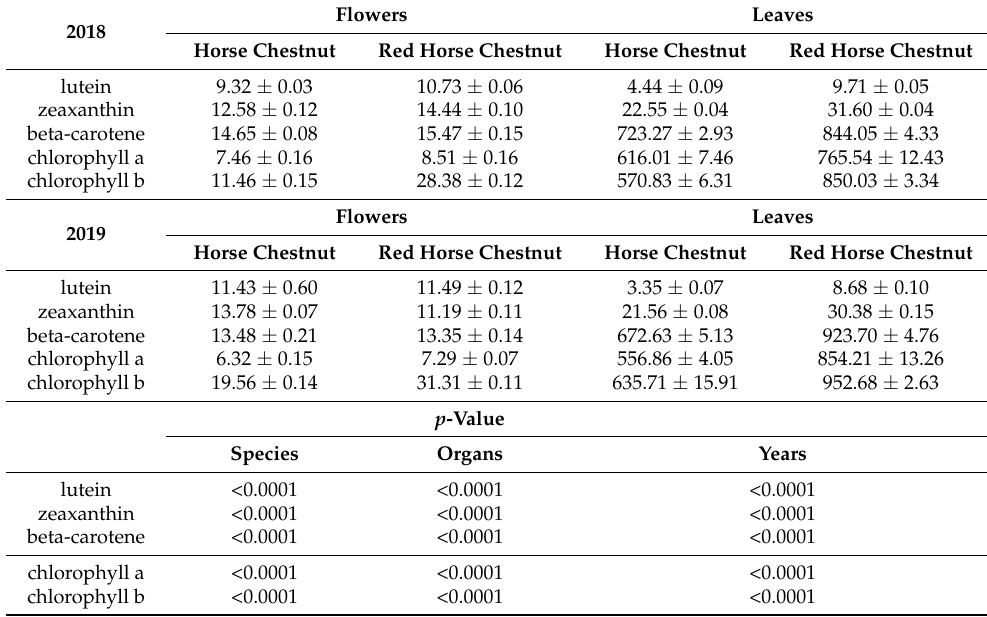
Table 2. Content of identified carotenoids and chlorophylls ( µ g/g FW) in both species of horse chestnuts’ flowers and leaves (mean value ± standard error).